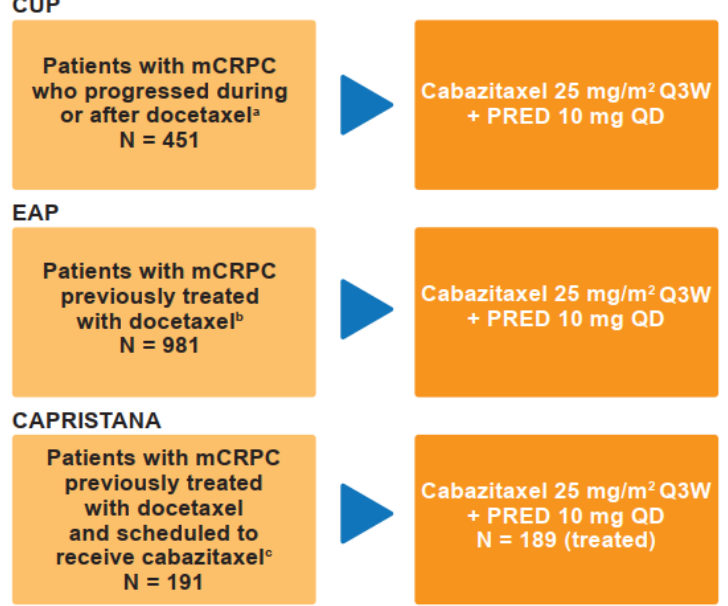
Figure 1. Study designs for the CUP, EAP and CAPRISTANA studies. a December 2010–May 2013; b July